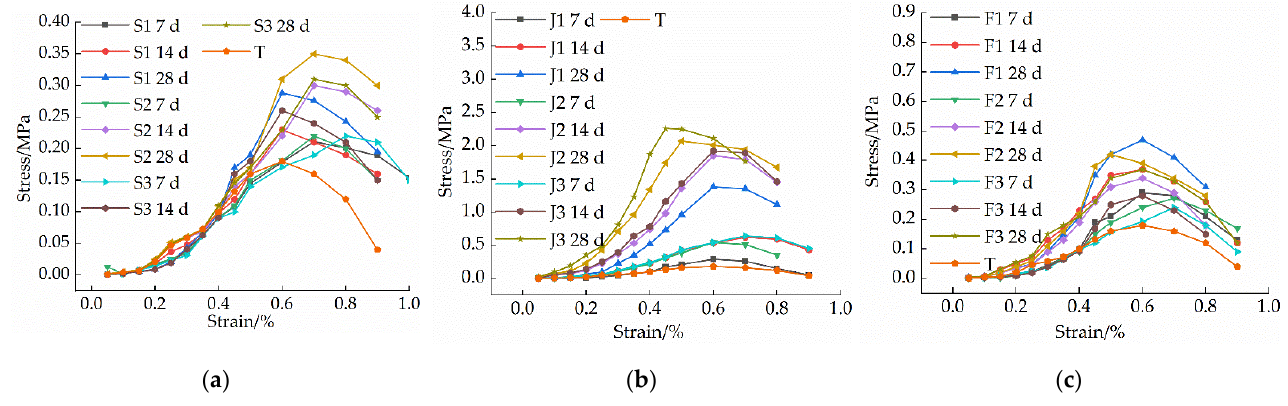
Figure 5. The stress-strain diagram of each group of samples: ( a ) Single mixed quicklime group; ( b ) Mono-doped sodium methyl silicate group; ( c ) Compounding group .